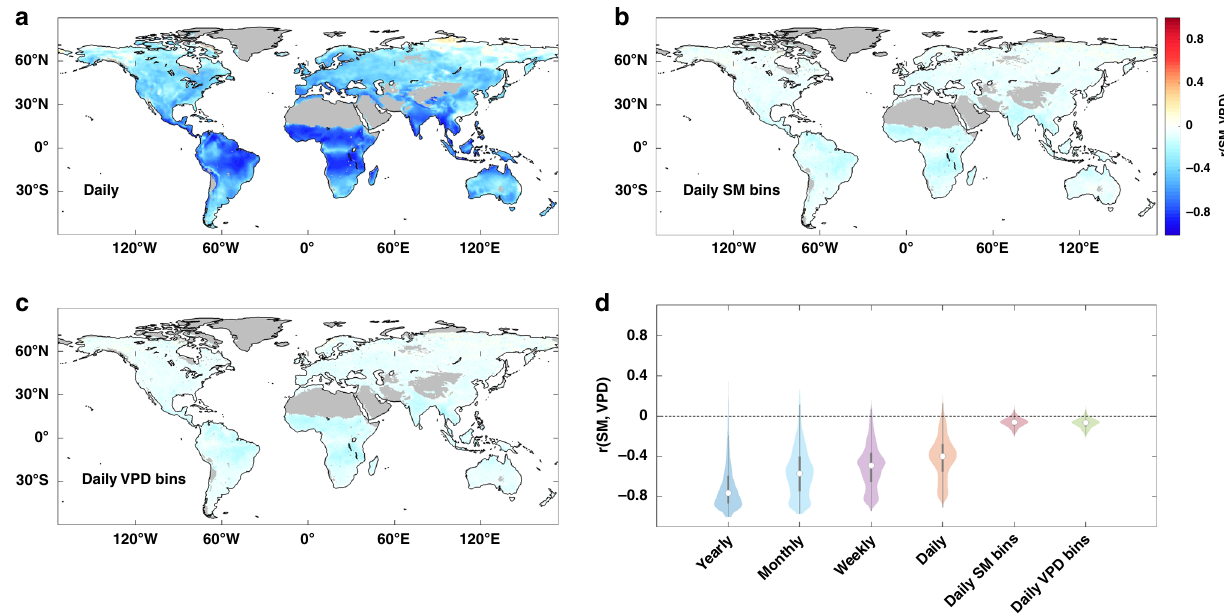
Fig. 2 Decoupling of soil moisture and vapor pressure de fi cit. a – c Spatial distribution of Pearson ’ s correlation coef fi cient between soil moisture (SM) and vapor pressure de fi cit (VPD) at daily scale, averaged over daily SM bins, and averaged over daily VPD. Regions with sparse vegetation and regions without valid data are masked in gray. d Violin plots of correlations between SM and VPD from yearly to daily bins across land vegetated areas. White dots indicate the median values, gray boxes cover the interquartile range, and thin gray lines reach the 5th and 95th